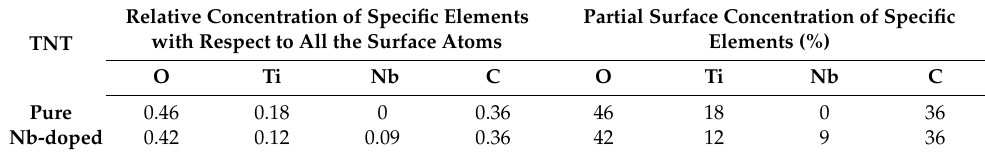
Table 1. Relative concentration of specific elements (with respect to all the surface atoms), and the corresponding partial concentration (in %) of the basic elements of pure and highly doped (12 wt %) Nb-TiO 2 nanotubes